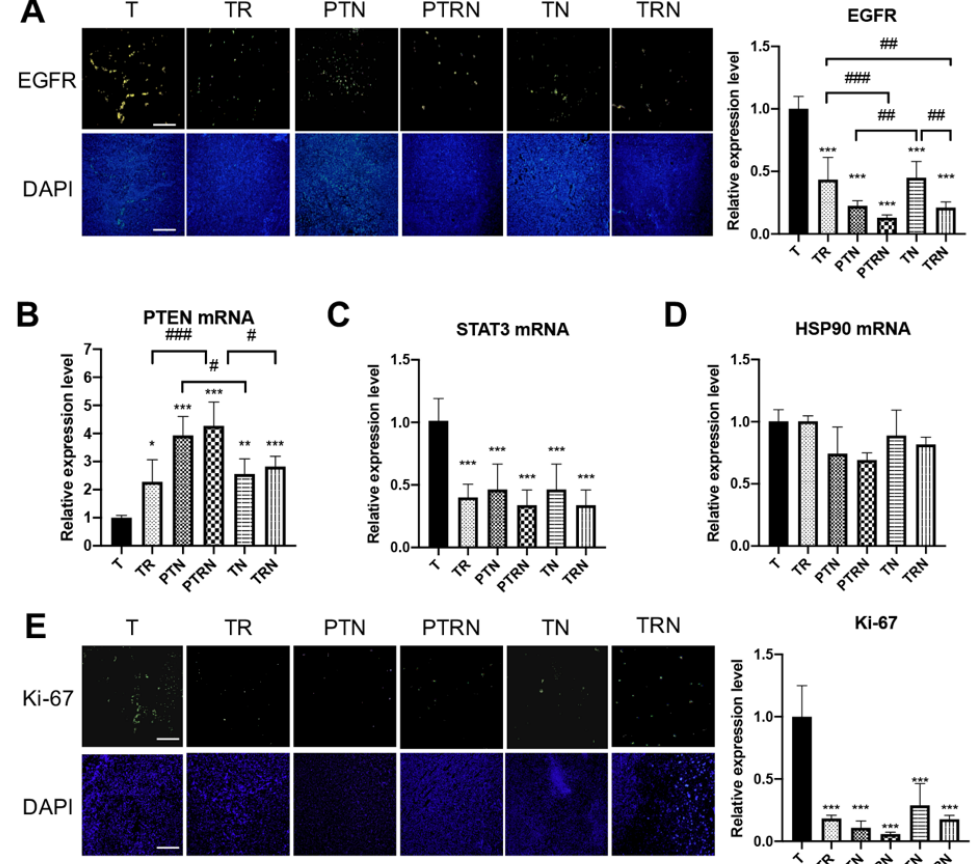
Figure 2. Total nutrition formula downregulates the expression of the epidermal growth factor receptor pathway in tumors receiving radiotherapy. ( A ) Immunofluorescence analysis for epidermal growth factor receptor (EGFR) in inoculated tumor tissues. Scale bar = 200 µ m. The relative expression levels of ( B ) PTEN, ( C ) STAT3, and ( D ) HSP90 were measured by RT-PCR. ( E ) Immunofluorescence analysis for Ki-67 in inoculated tumor tissues. Scale bar = 200 µ m. Six tissue sections of each group were selected for immunofluorescence, RT-PCR, and statistical analysis. Data are expressed as means ± SD. *, p < 0.05 as compared to the T group. **, p < 0.01 as compared to the T group. ***, p < 0.001 as compared to the T group. #, p < 0.05 as compared between two groups. ##, p < 0.01 as compared between two groups. ###, p < 0.001 as compared between two